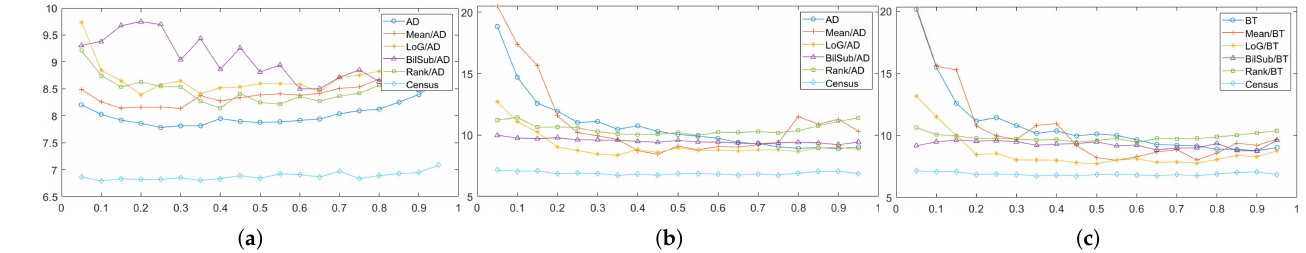
Figure 13. Errors of combinations of cost and image filter using the SGM and GC stereo methods, according to the variation of the pattern contrast parameter. ( a ) SGM/AD. ( b ) GC/AD. ( c ) GC/BT.